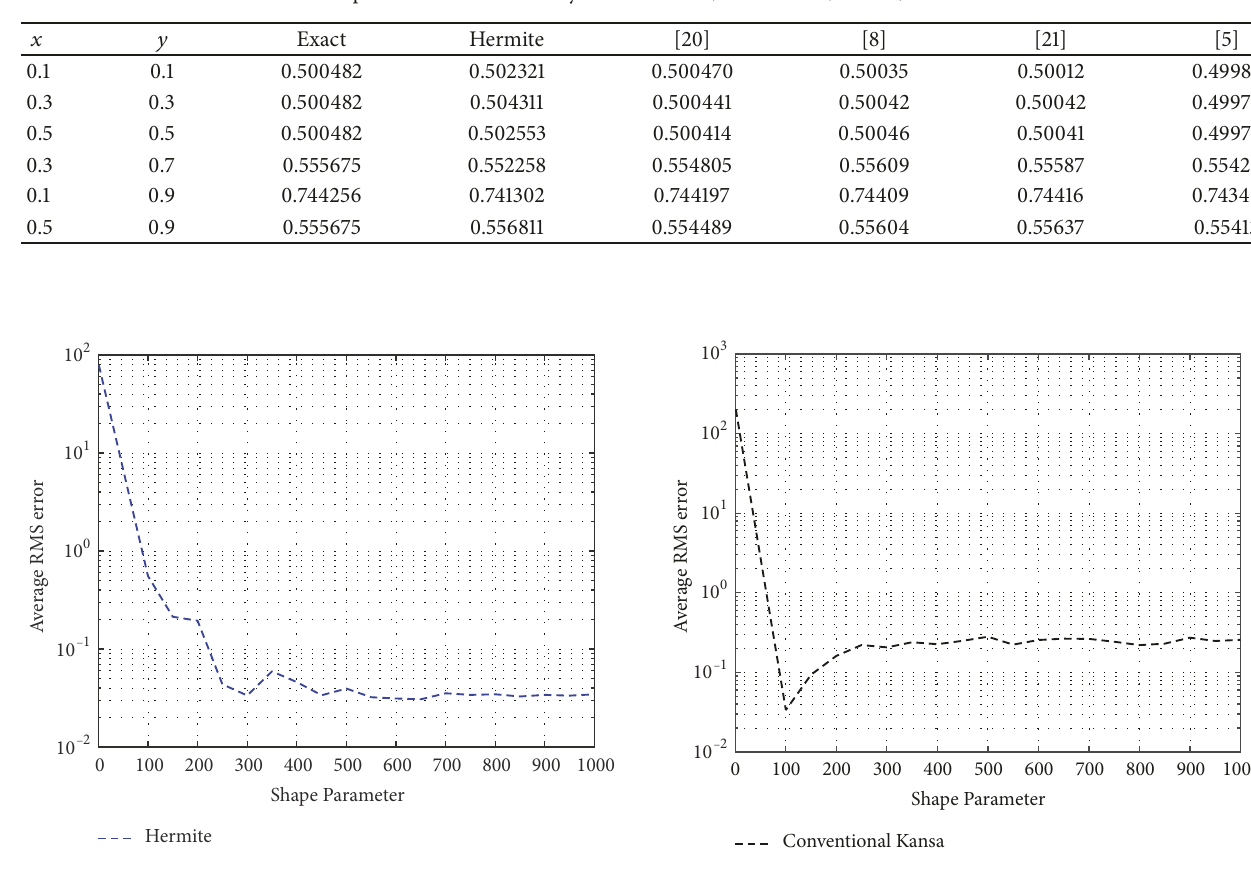
Figure 4: Effect of the Gaussian shape parameter ( 𝜀 ≫ 1.5 ) on the result accuracy for the conventional Kansa scheme computed at Re = 10 with 𝑡 = 0.5, Δ𝑡 = 0.005 , and 𝑁 = 10 × 10